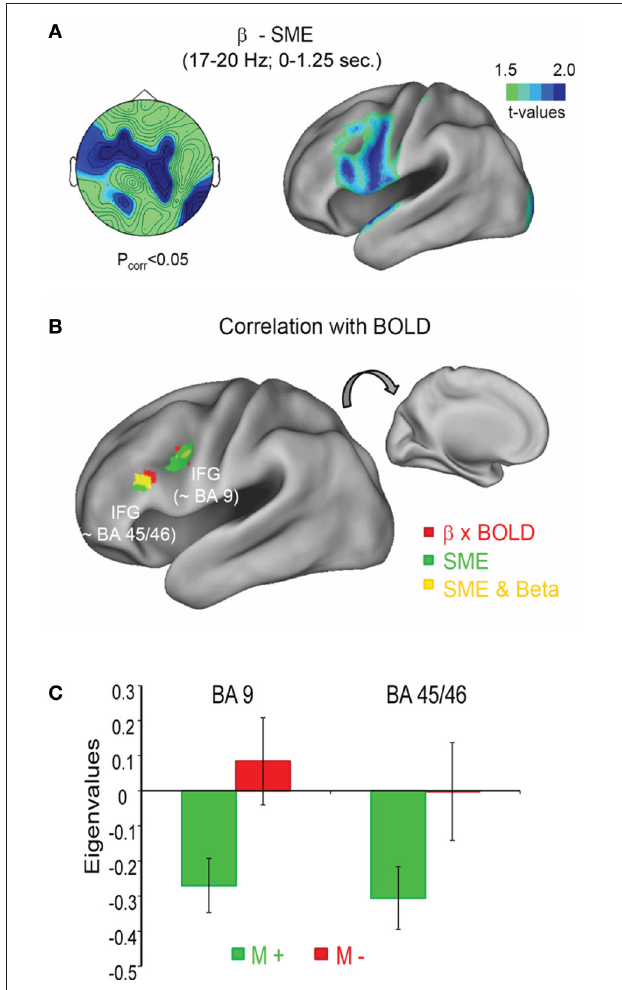
FIGURE 3 | Beta power decrease and BOLD signal during memory formation. (A) The topography of the beta SME (left) is shown together with the source localization (right). Stronger power decreases for subsequently remembered in contrast to forgotten items was observed in the left inferior frontal gyrus (IFG). (B) The negative correlation between beta power and BOLD signal is shown in red, together with the SME in the fMRI, shown in green; yellow areas denote an overlap between fMRI SMEs and negative BOLD—beta power correlations. (C) The correlation between beta power and BOLD is shown for two regions within the left IFG as a function of subsequent memory (M + vs. M − ). Figure adapted from Hanslmayr et al.